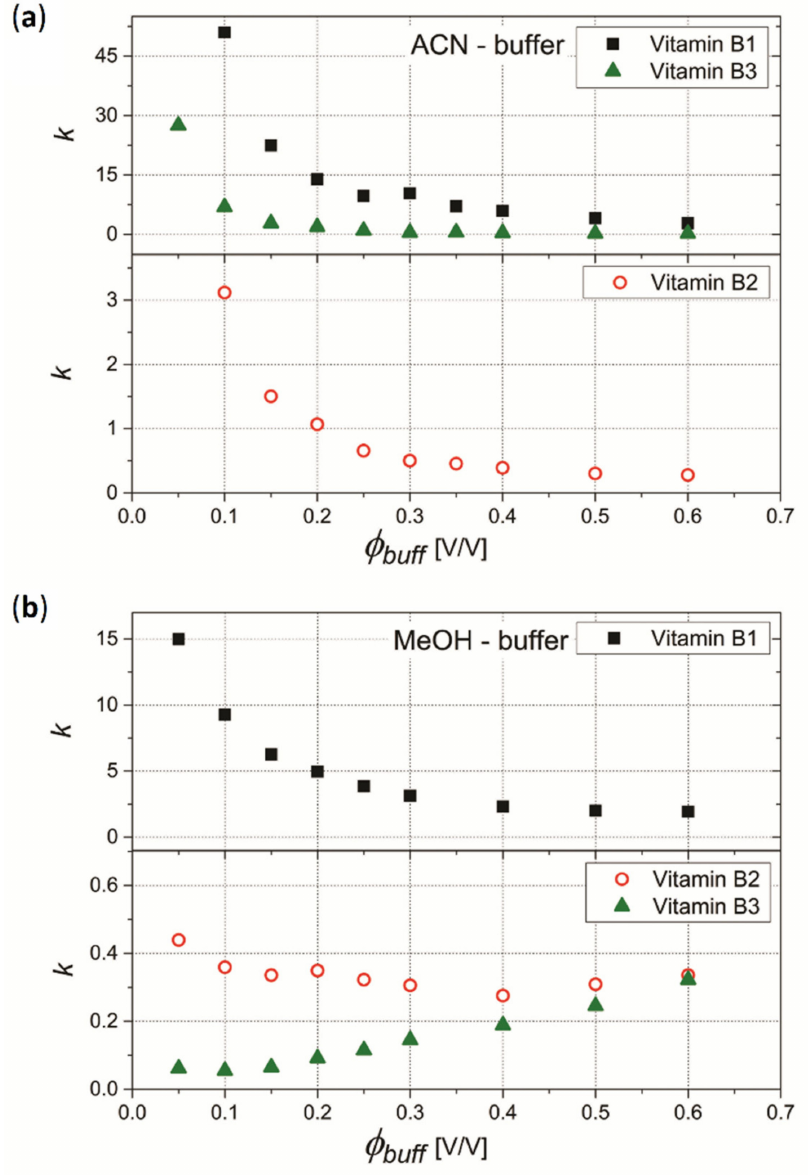
Figure 2. Effects of mobile phase composition ϕ buff on retention coefficient k of vitamins obtained using column E (Eurospher II 100–5 HILIC) with: ( a ) acetonitrile and ( b ) methanol as mobile phase